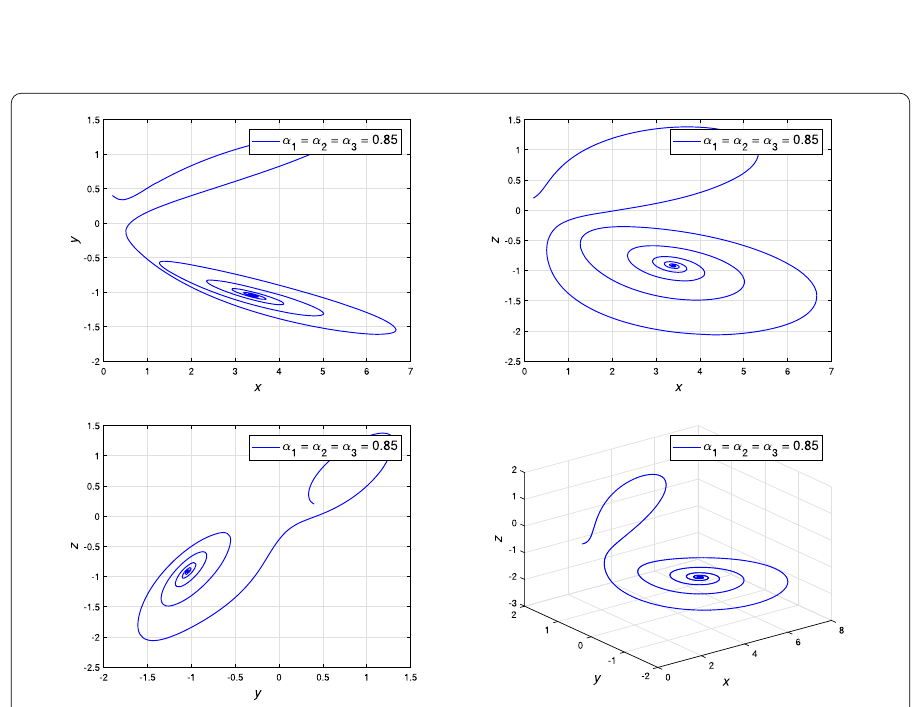
Figure 2 State variables of the fractional-order model (21) in the phase-plane ( α i = 0.85, i =